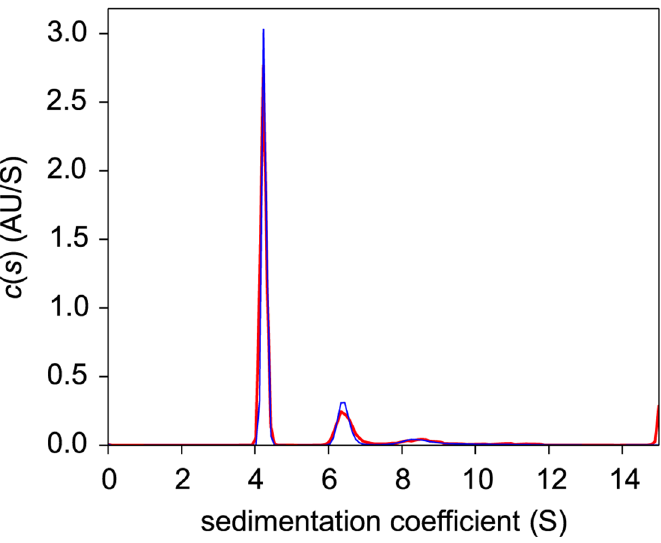
Fig 5. Sedimentation coefficient distributions from a rectangular cell. Sedimentation coefficient distributions calculated from the data in Fig 4 for rectangular (magenta) and sectorial (blue) geometry.